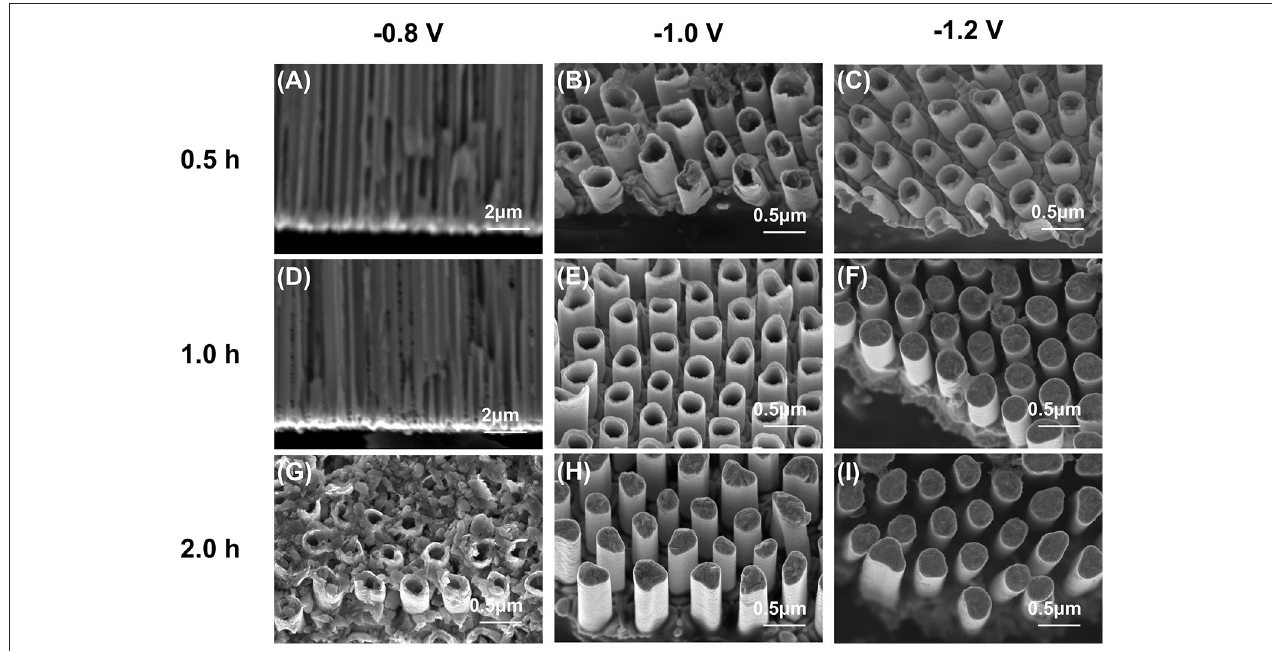
FIGURE 1 | SEM images of the products deposited at different potential and time. (A,B) cross-section image with AAO template. (C–I) products after removing the AAO template.